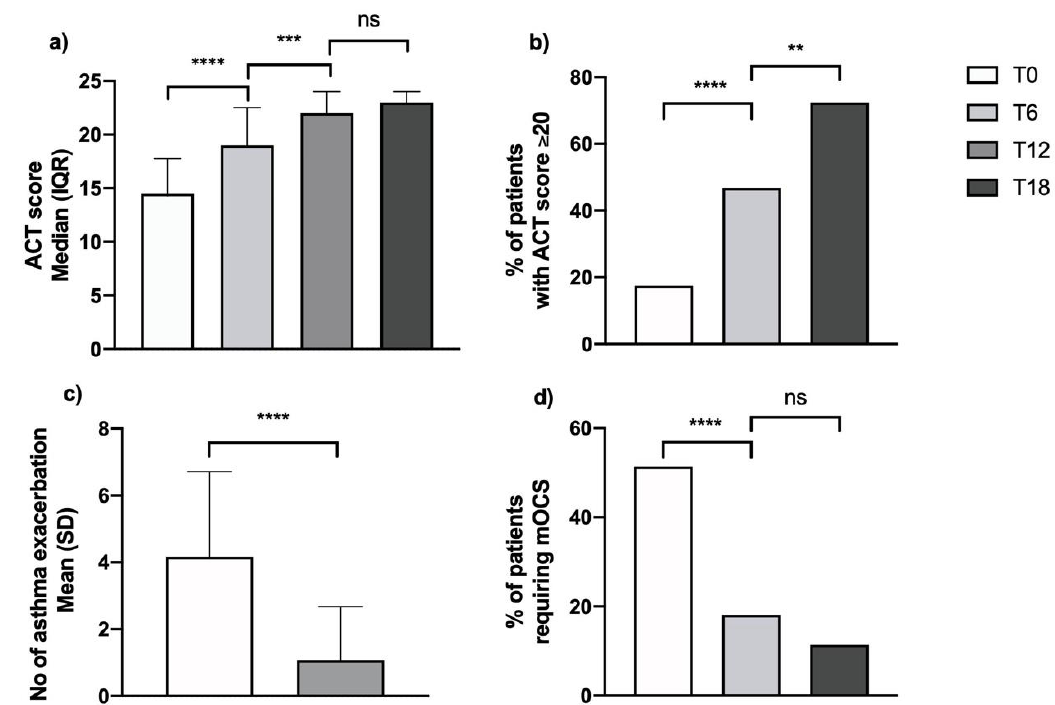
Figure 2. Effects on clinical parameters during treatment with mepolizumab on ( a ) ACT score; ( b ) % of patients with good asthma control; ( c ) asthma exacerbations; ( d ) % of patients requiring maintenance OCS (**, p = 0.002; ***, p = 0.0002; ****, p < 0.0001; ns, non-significant).